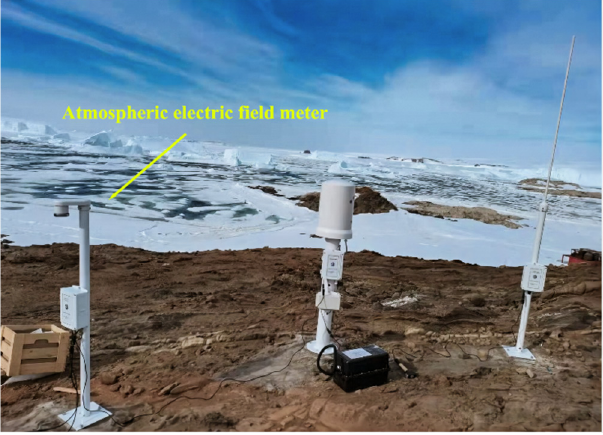
Figure 3. Photo of the observation scene at the Antarctic Chinese Zhongshan Station.